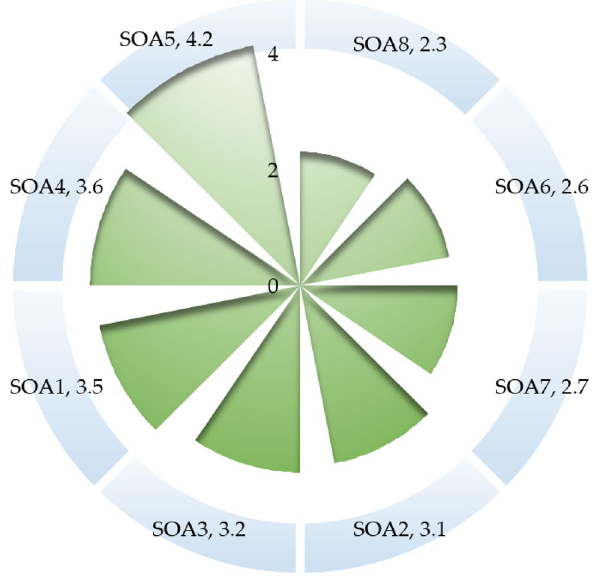
Figure 5. Sustainability evaluation of ELV recycling system from social